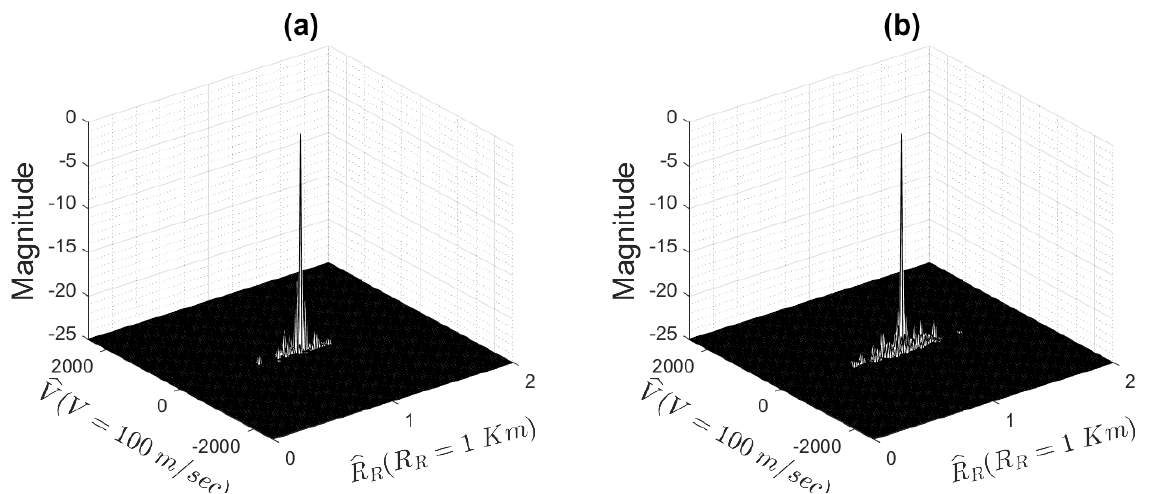
Figure 11. Cross–ambiguity surface between { s rec ( t ) , r tgt ( t ) } for ( a ) the Lorenz CBFM waveform and ( b ) the Burke–Shaw CBFM